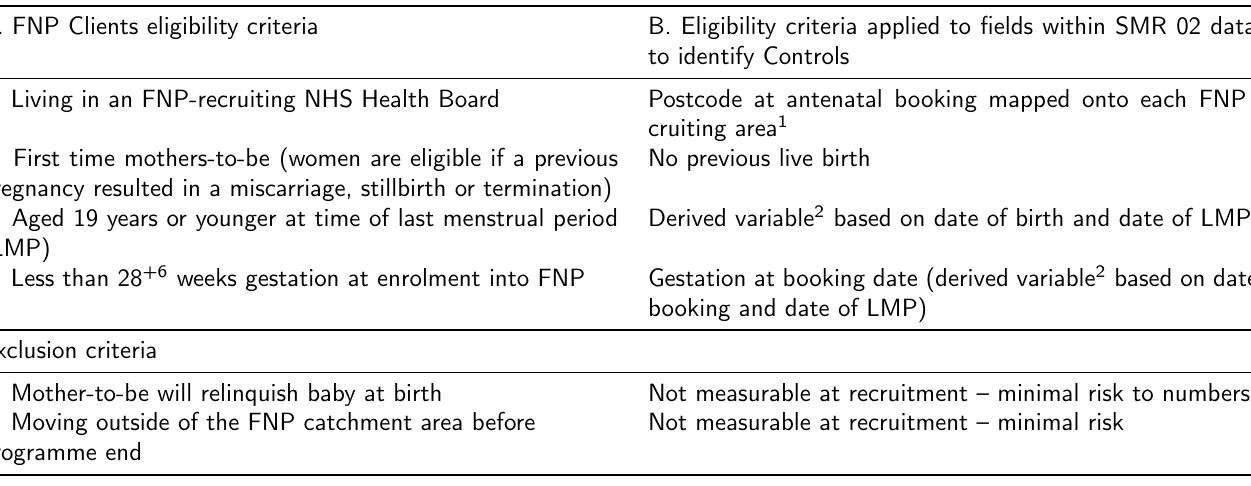
Table 1: Maternal baseline characteristics measured at (or before) date of antenatal